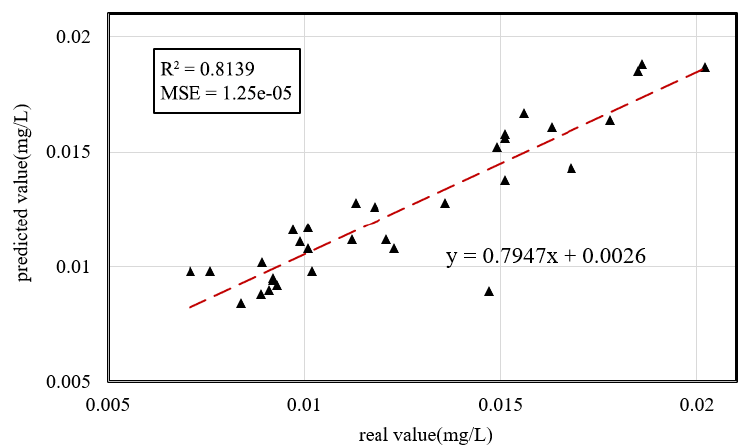
Figure 7. Fitting curve of the ETR retrieval model for the accuracy